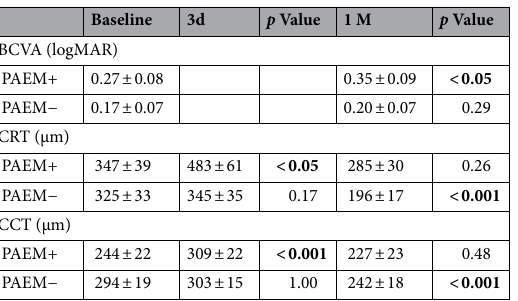
Baseline 3d p Value 1 M p